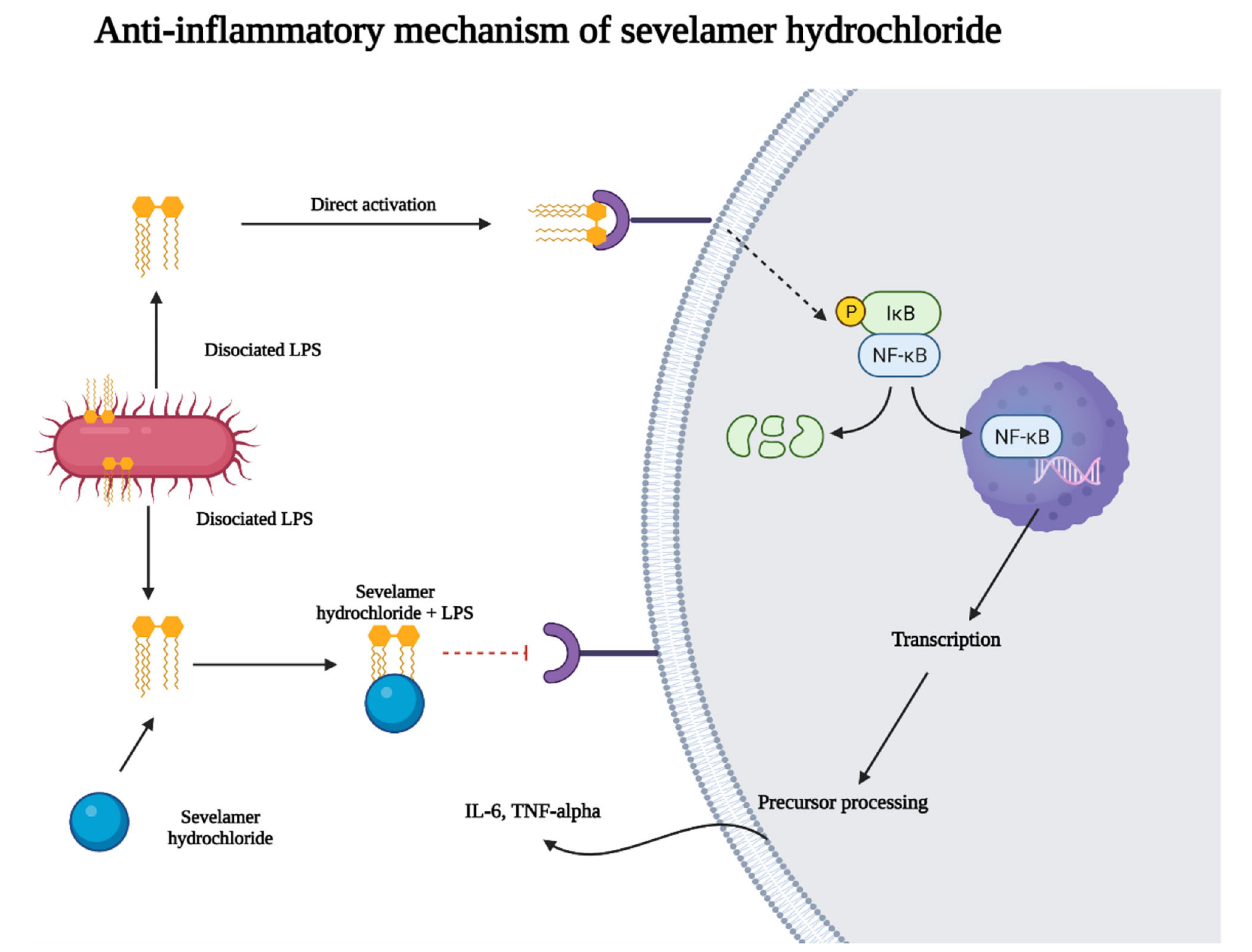
FIGURE 3 | Anti-inflammatory of sevelamer hydrochloride. Sevelamer hydrochloride can bind to endotoxins present in the intestinal lumen. In this way, the negatively charged lipid A portion of endotoxins binds to sevelamer. Endotoxins are a component of the cell wall of gram-negative bacteria and are a potent stimulus for activating the innate immune system that leads to the transcription of pro-inflammatory cytokines. In this way, sevelamer hydrochloride could exert its anti-inflammatory effect.